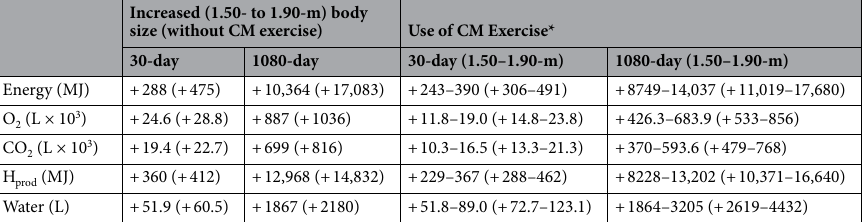
Table 4. Absolute increase in energy expended, oxygen (O 2 ) consumed, carbon dioxide (CO 2 ) and heat produced (H prod ), and water required for hydration, during 30-day and 1080-day missions resulting from the increase in body size alone between a ‘small-sized’ (all individuals with a stature of 1.50-m) and ‘large-sized’ (all individuals with a stature of 1.90-m) female crew, and the use of aerobic countermeasure (CM) exercise. In brackets, comparable values from the theoretical male astronaut populations (see 9 ). *A range of values is presented for ‘Use of CM Exercise’ data because the magnitude of the effect of CM exercise increases with increasing